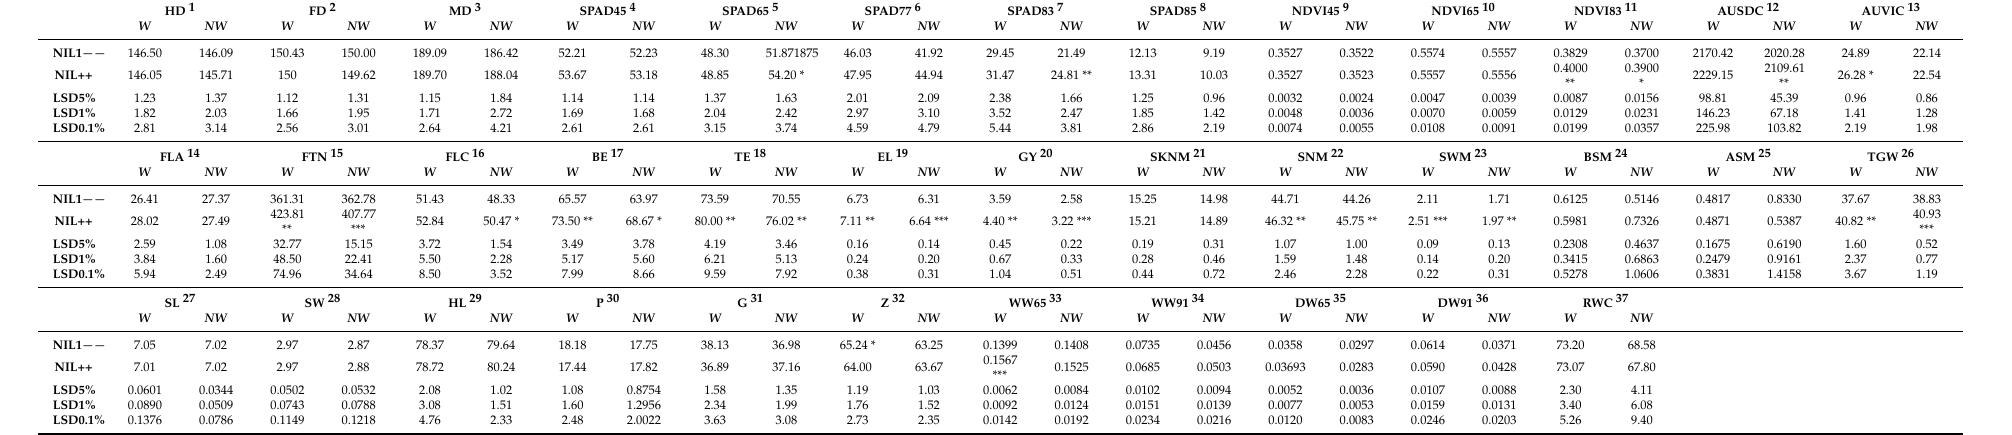
Table 3. Mean values of plant development, morphological and physiological traits and of yield components recorded for QYld.idw-3B −− and QYld.idw-3B++ near-isogenic lines of spring durum wheat in rain-fed and well-watered treatments. *, ** and *** denote significant differences within treatments between the QYld.idw-3B −− and QYld.idw-3B++ near-isogenic lines at the p < 0.05, 0.01 and 0.001 levels of probability, respectively (2014).